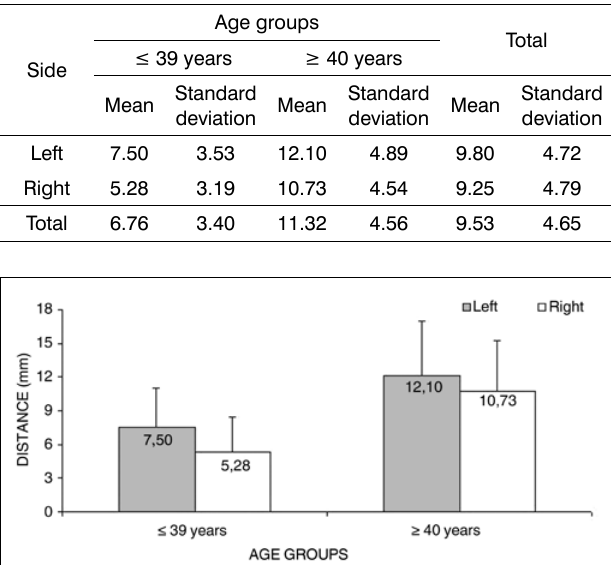
Table 6. Medida 3 quanto à faixa etária e lado. em mm. expressa em média±desvio-padrão.